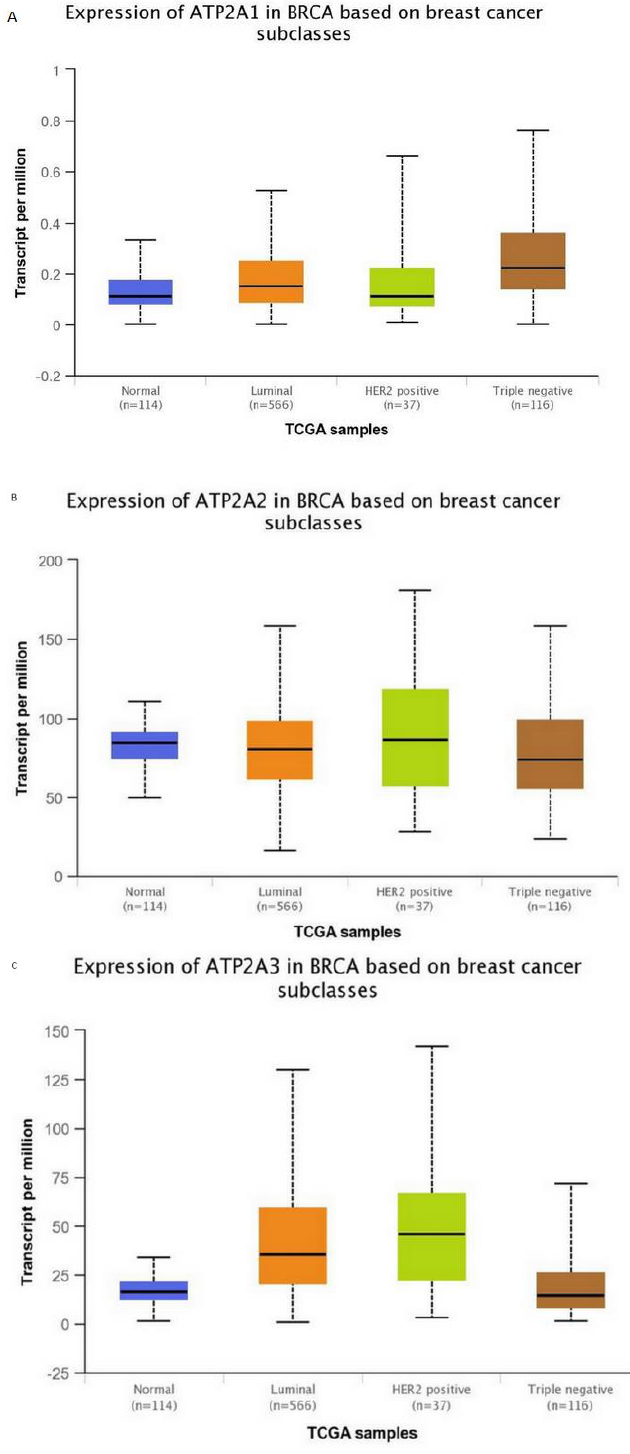
Figure 3. SERCA isoforms expressions. ( A ) ATP2A1 expression in breast cancer subclasses. ( B ) ATP2A2 expression in breast cancer subclasses. ( C ) ATP2A3 expression in breast cancer subclasses. Normal n = 114, luminal n = 566, HER-positive n = 37, and triple-negative n = 116. Data collected from: http://ualcan.path.uab.edu/.